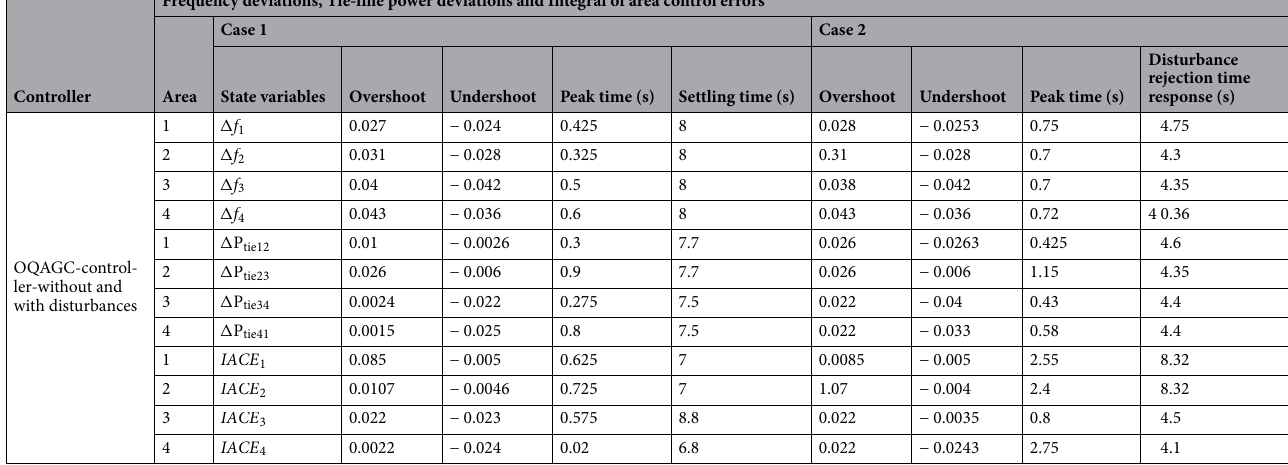
Table 4. Performance of OQAGC controller without and with disturbances.